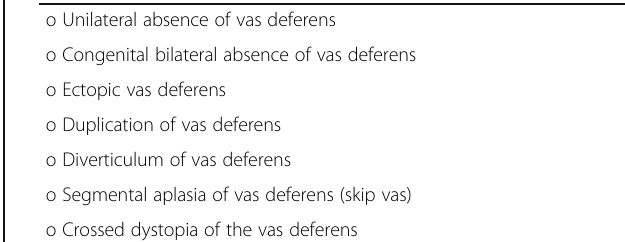
Table 1 Anomalies of the vas deferens [5]